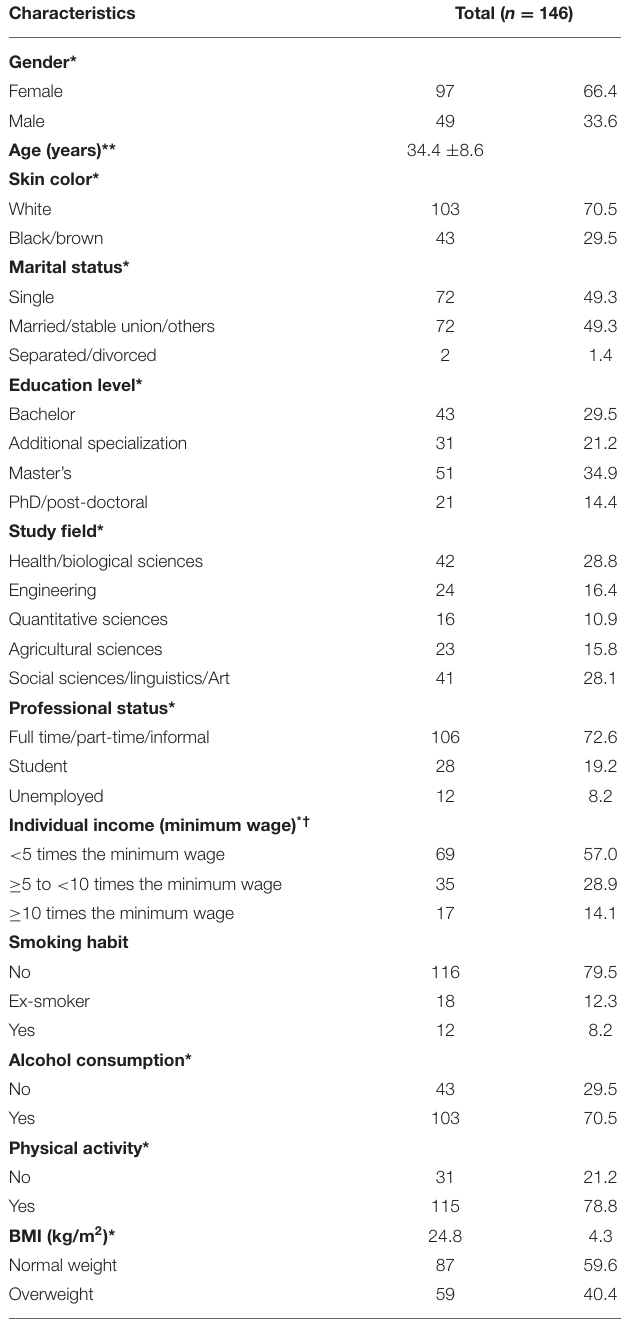
TABLE 1 | General characteristics of participants selected for validity and reproducibility of the food frequency questionnaire ( n = 146 participants).